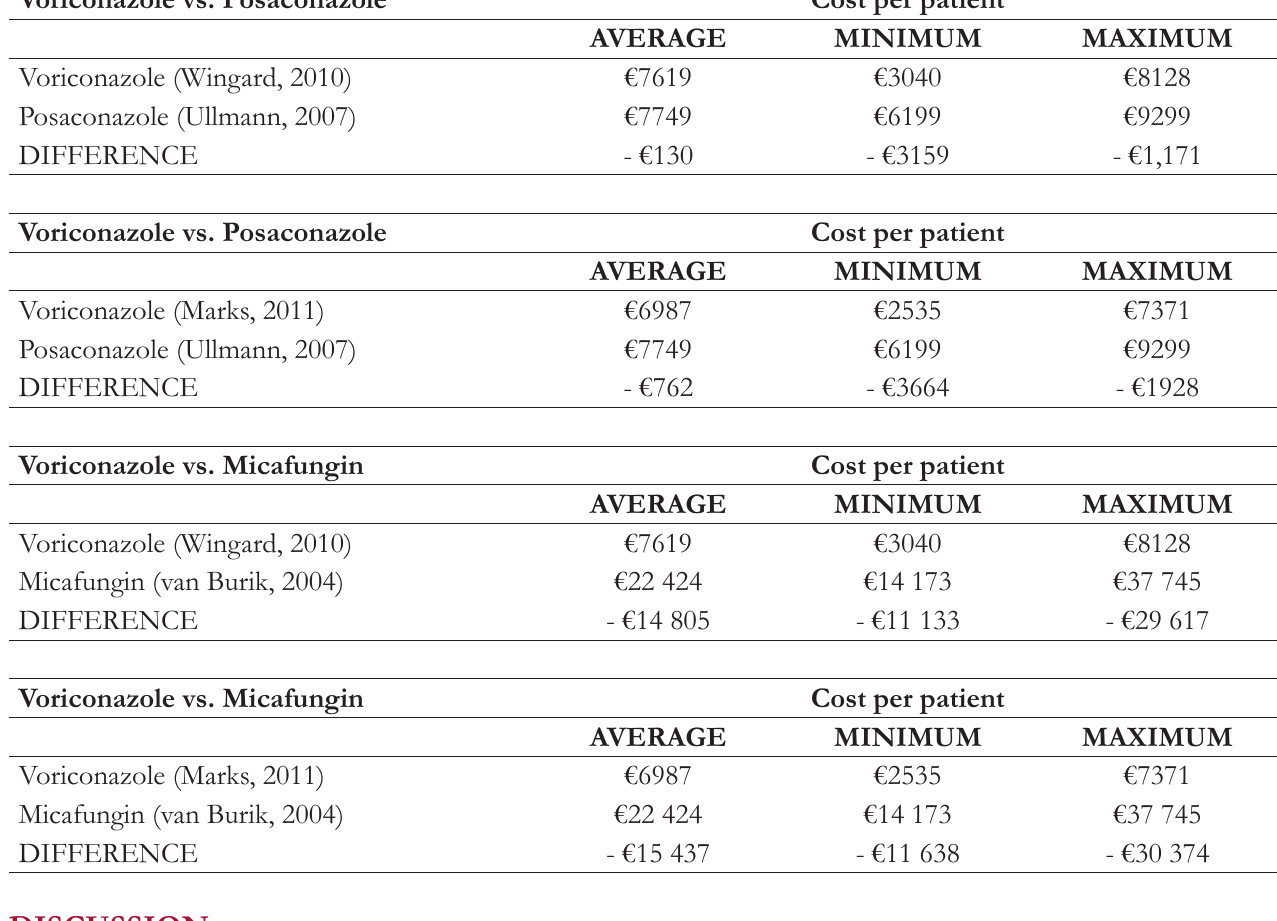
Table 3. Results of Deterministic Modeling Analysis (Base Case) Voriconazole vs. Posaconazole Cost per patient